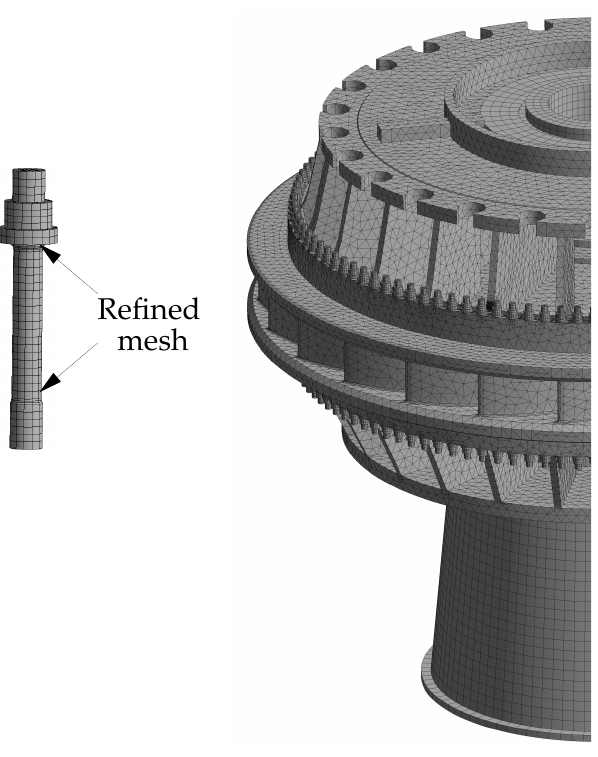
Figure 10. Finite element mesh of the stationary structures and the refined mesh of the bolts. As with the fluid simulation, three sets of finite element meshes containing 1.2 million, 1.6 million and 2.7 million elements were built to perform the mesh sensitivity